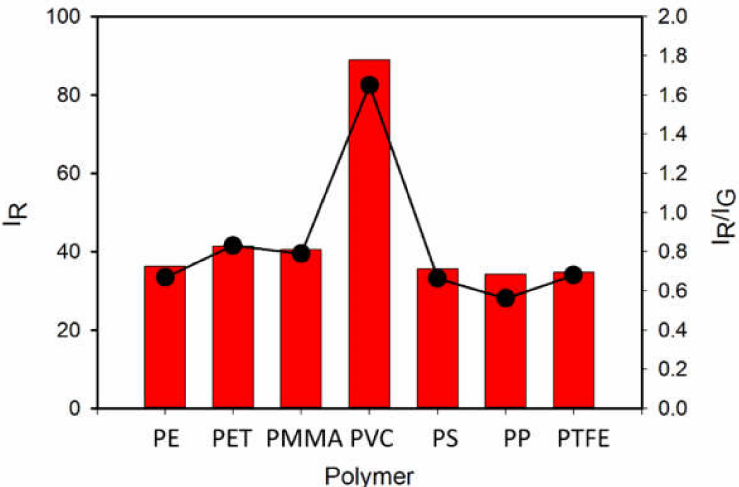
Figure 8. Black dots show the intensity on the red channel (I R ) of the fluorescence images of PE, PET, PMMA, PVC, PS, PP and PTFE particles after 2 h incubation with P in buffered water solution (pH = 7) at concentration 8 µ M obtained with a fluorescence inverted microscope upon illumination with a blue LED diode in epifluorescence mode. Images were acquired with a conventional CMOS camera directly in the P solutions, without any washing. The ratio of the intensities on the red and green channels is plotted as red